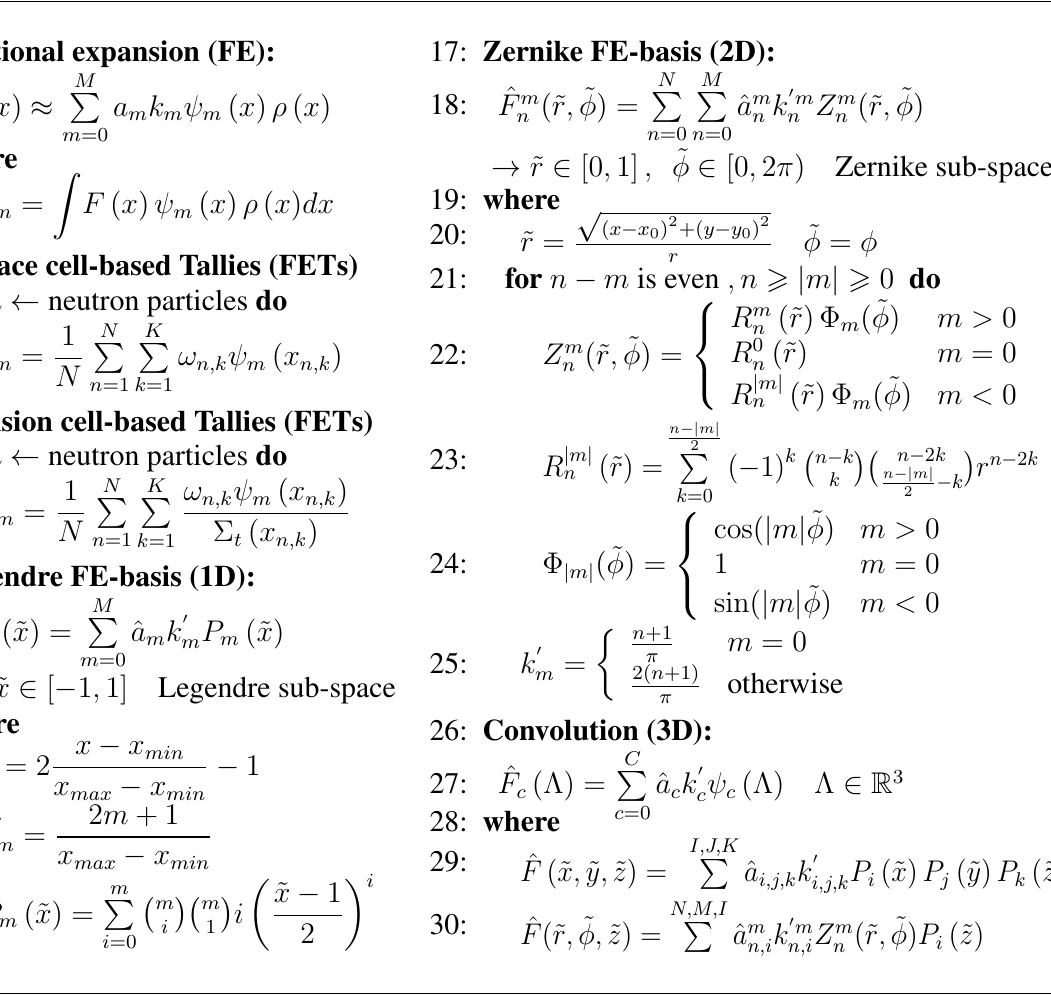
Algorithm 4: Functional expansion tallies